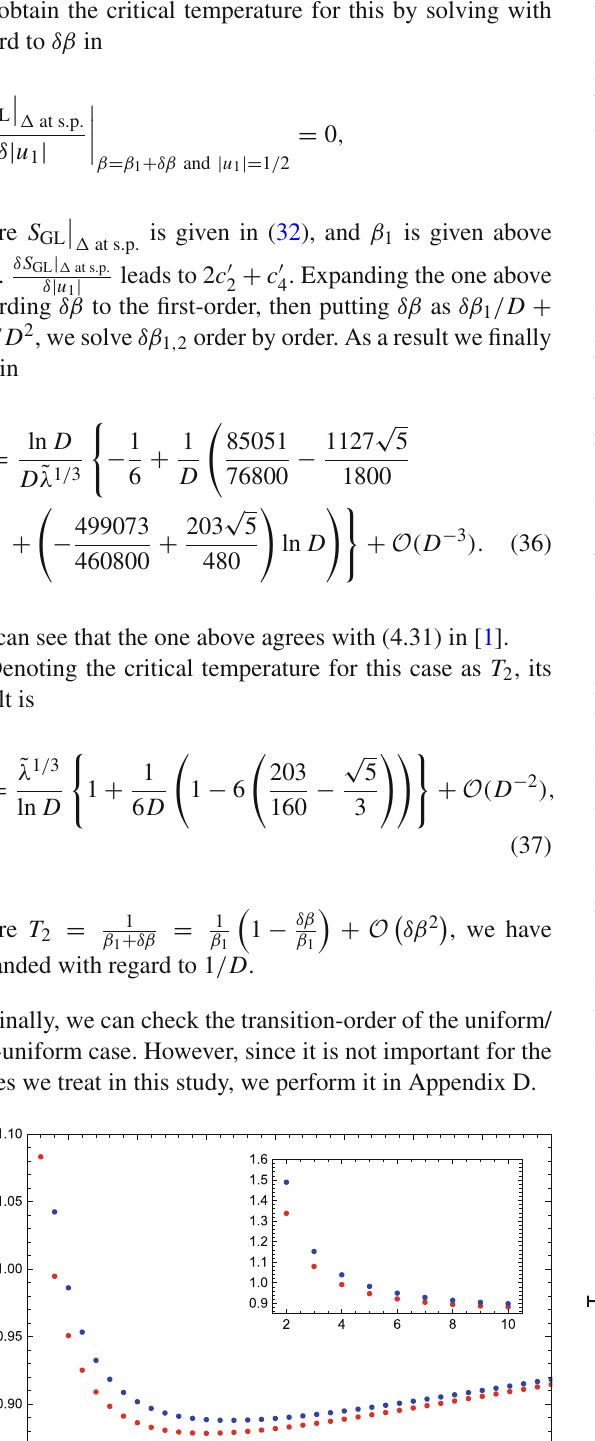
for small D , while gets smaller as D gets larger. These are an opposite tendency from GL instabilities in gravities and RP instabilities in fluid